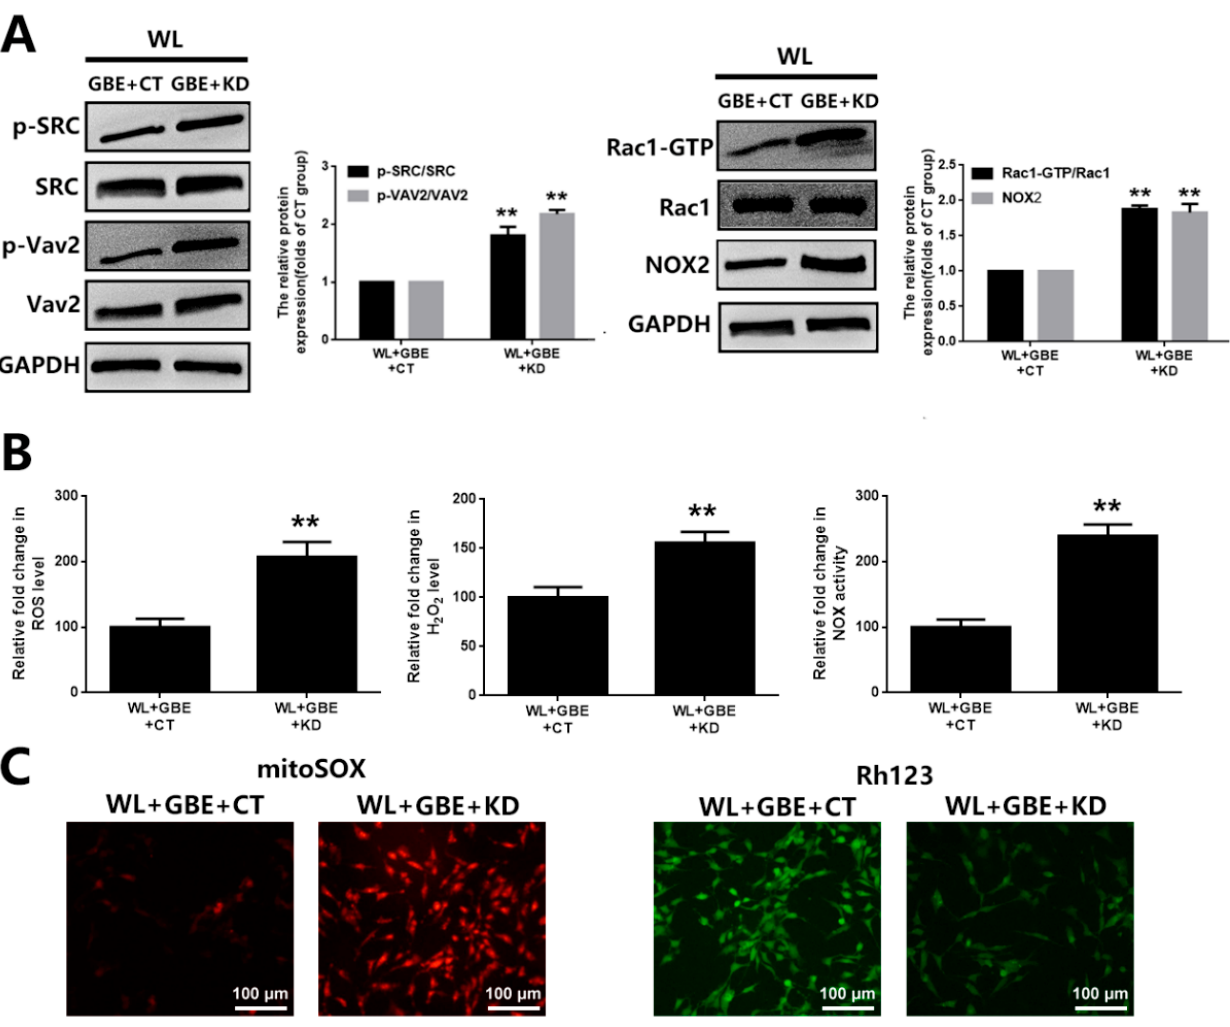
Figure 6. CAV-1 silencing attenuated the effect of GBE on redoxosome activation in 661W cells exposed to WL illumination. ( A ) Cells from the 661W cell line with or without CAV-1 silencing were pre-treated with GBE (100 mg/L, 24 h) and then exposed to WL (4000 lux) for 1 h. The expressions of redoxosome-related proteins were assessed by Western blot analysis. ( B ) The 661W cells with or without CAV-1 silencing were pre-treated with GBE (100 mg/L, 24 h) and then exposed to WL (4000 lux) for 30 min. The level of intracellular ROS was assessed by DCFH-DA staining (left panel). The level of intracellular H 2 O 2 was assessed using titanium sulfate colorimetry (middle panel). The activity of NOX was assessed using DCPIP assay (right panel). ( C ) The level of mitochondrial ROS was assessed via mitoSOX staining (left panel) and that of MMP was assessed by rhodamine123 staining (right panel). ** p < 0.01 vs. WL + GBE + CT. WL: white light, DCPIP: 2,6-dichlorophenol-indophenol, mitoSOX: mitochondrial superoxide indicator, Rh123: rhodamine123 CT: 661W cells without CAV − 1 silencing; KD: 661W cells with CAV − 1 silencing.